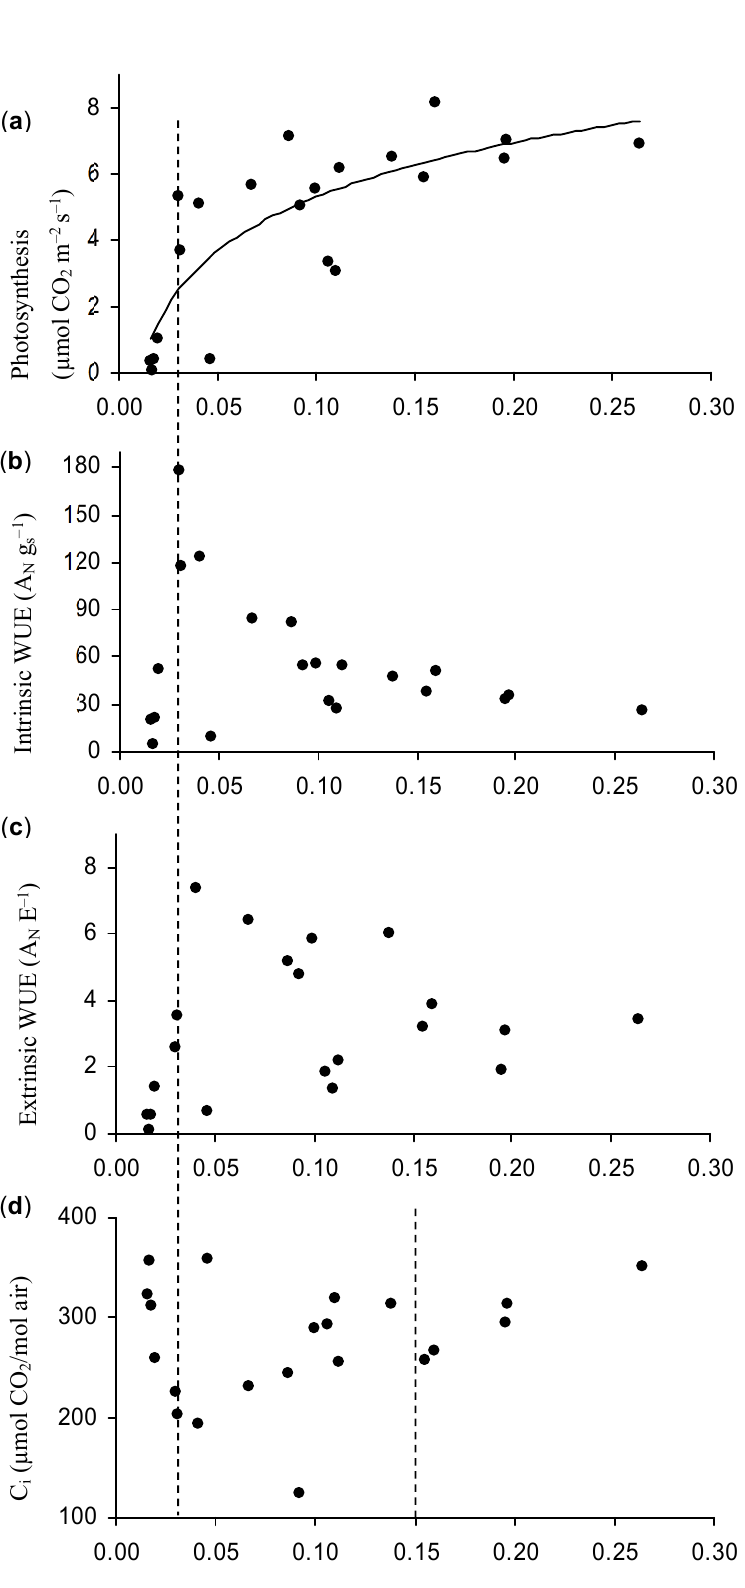
Figure 7. Relationship between leaf stomatal conductance (g s ) and leaf photosynthesis (A N ), intrinsic WUE (A N g s − 1 as µ mol CO 2 mol H 2 O − 1 ), extrinsic WUE (A N E − 1 as mmol CO 2 mol H 2 O − 1 ) , and sub-stomatal CO 2 concentration (C i ) of primary leaves of the grapevine in the morning in Stage III. Values are means and error bars represent SE ( n = 3). E: